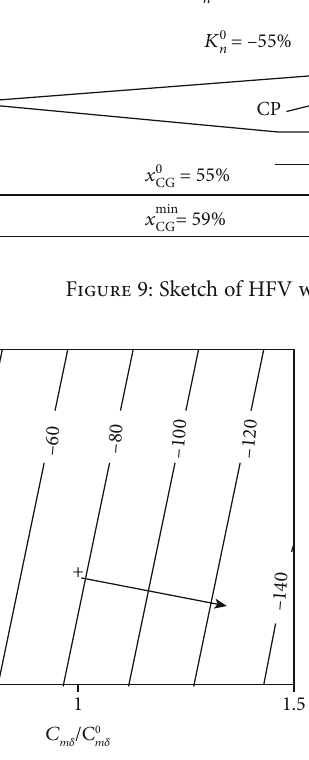
Figure 10: Variation in K min the baseline